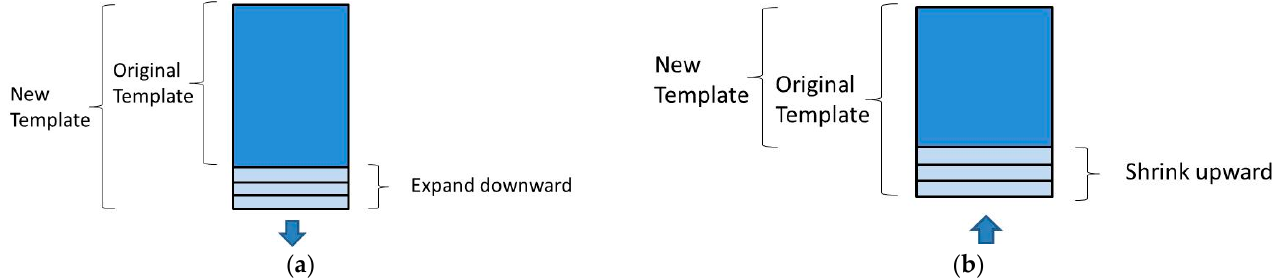
Figure 5. Adaptive adjustment of the bottom side of the template in the ADMTCF algorithm: ( a ) expanding downward; ( b ) shrinking upward.